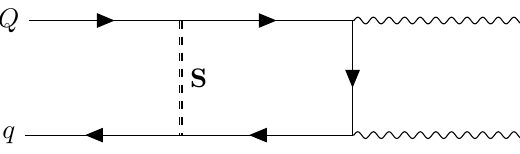
Figure 2 . A one-loop diagram that generates the (cid:22) Q(cid:27) (cid:22)(cid:23) qF (cid:22)(cid:23) operator in a UV completion of L with new